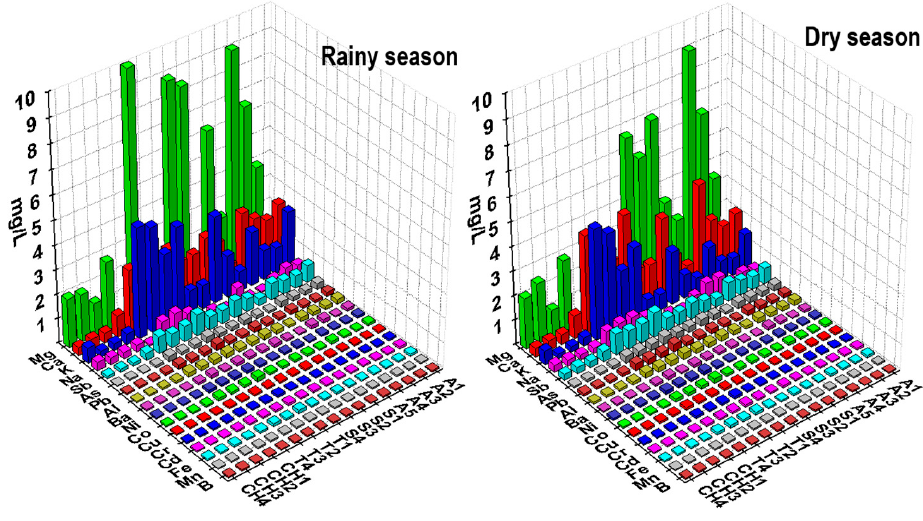
Figure 7. Variation of metal levels in water sources.